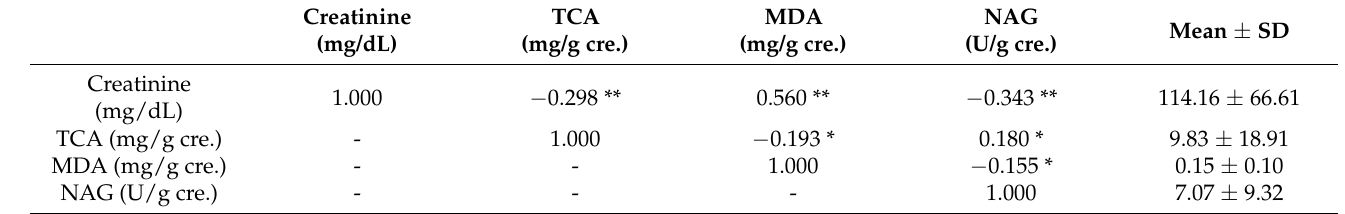
Table 2. Average concentrations of creatinine, TCA with MDA and NAG and correlation matrix (N = 180).